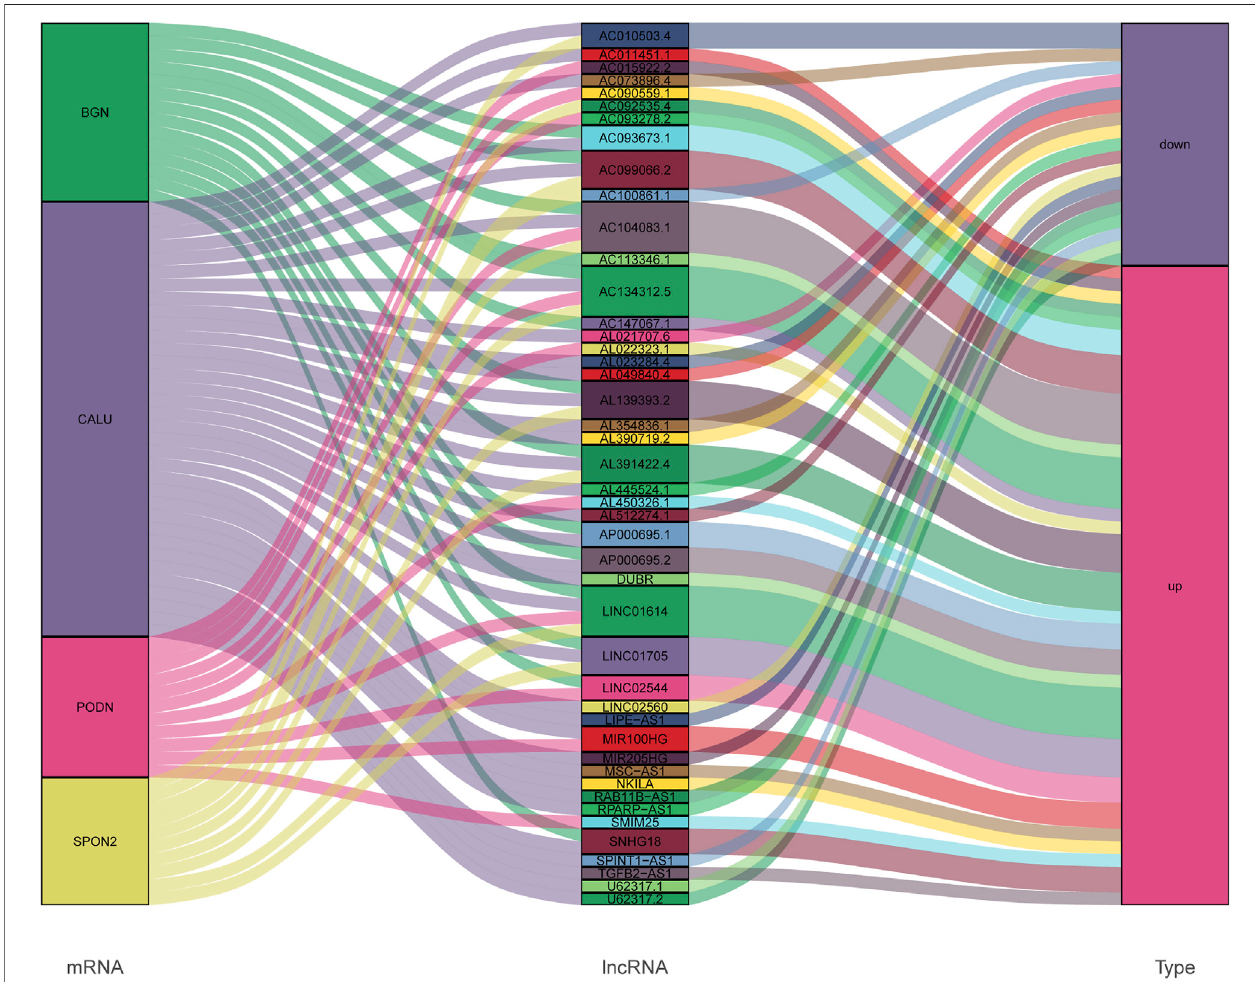
FIGURE 7 | The relationship between the CALU, BGN, POND, SPON2 , and lncRNAs.